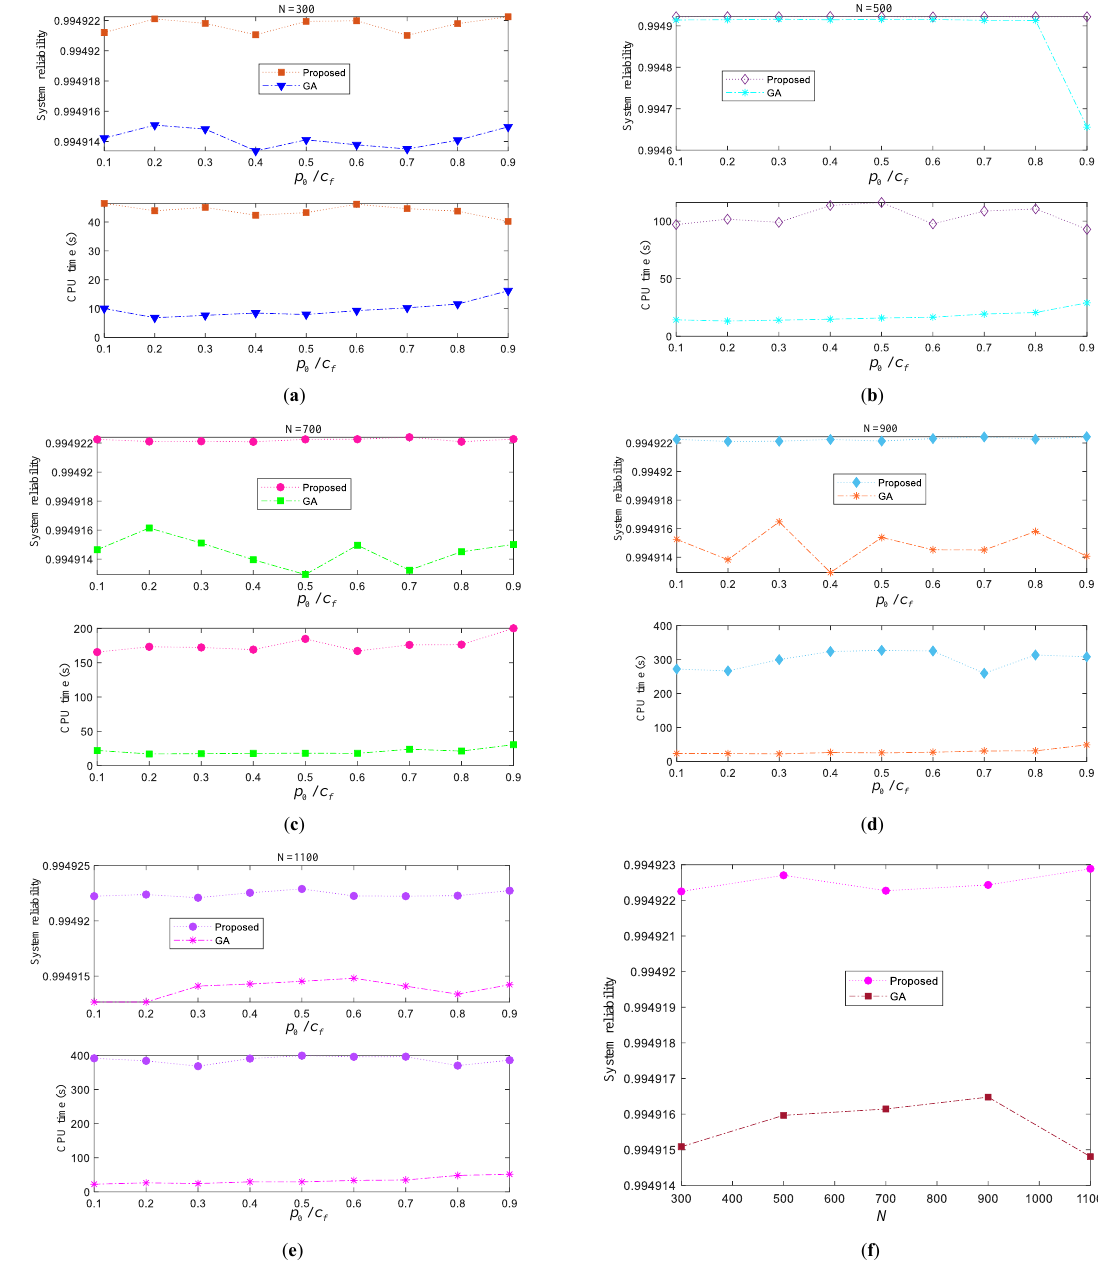
Figure 11. Results of the Lin/Con/3/50:F system. ( a ) Results under N = 3100; ( b ) Results under N = 500; ( c ) Results under N = 7100; ( d ) Results under N = 9100; ( e ) Results under N = 1100; ( f ) Optimal system reliability under different N